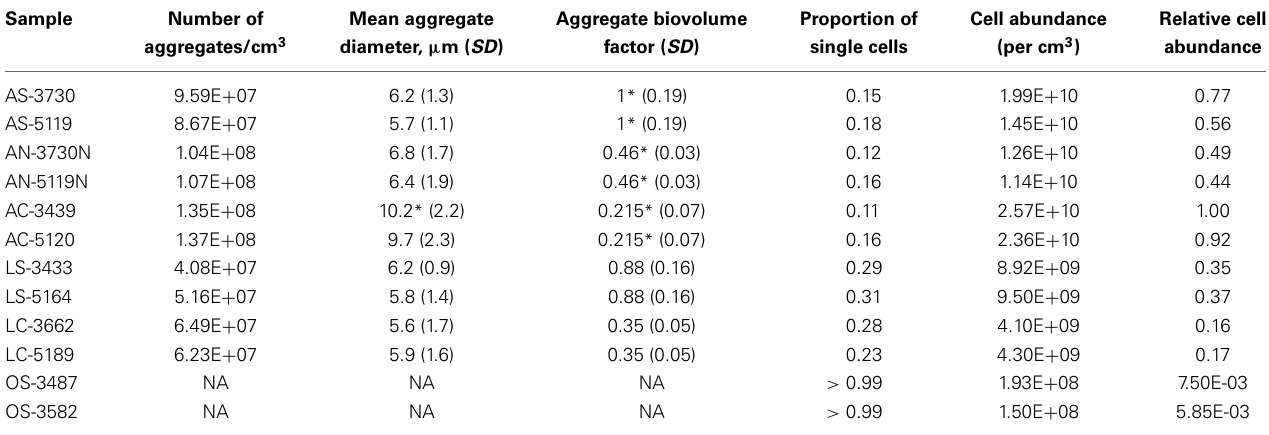
Table 2 | Cell abundance parameters from all seep-associated